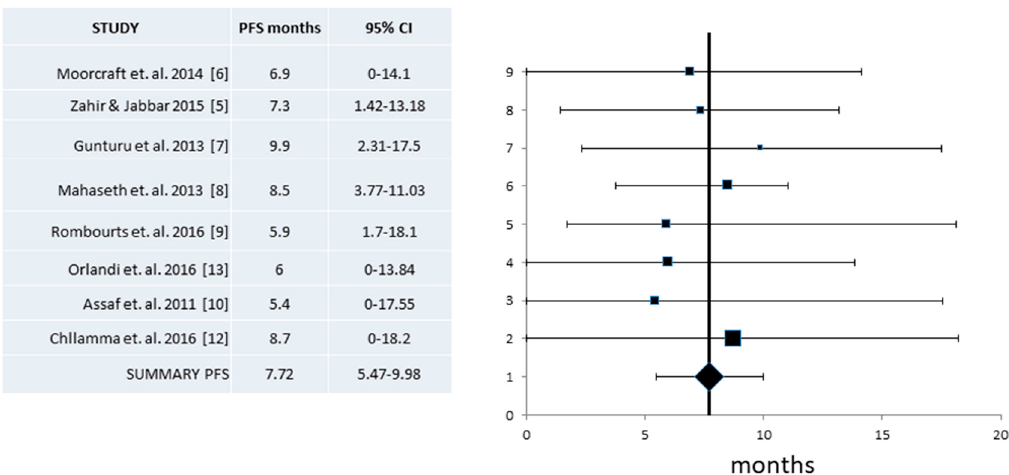
Figure 4. Pooled analysis of Progression-Free Survival (PFS) and 95% Confidence Intervals (CI) from published series. Eight studies with a total of 266 patients that provided information for the PFS were included in this analysis and revealed an overall PFS of 7.72 months (95% CI 5.47–9.98 months).